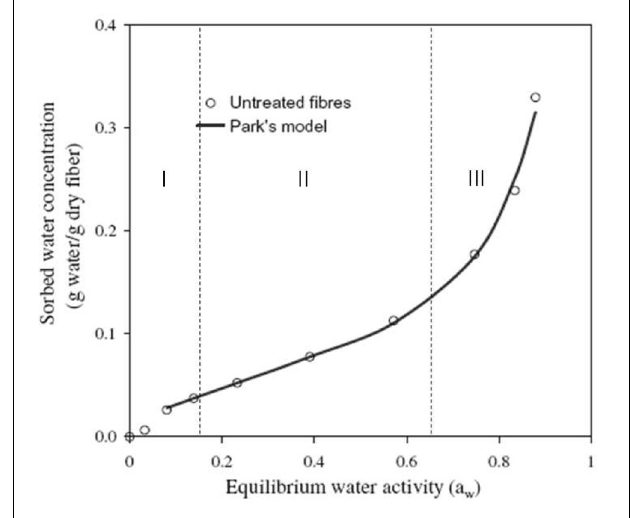
FIGURE 6 | Equilibrium water vapor sorption isotherm for modified agave fibers at 25 ◦ C [inspired by Bessadok et al. (2009)].